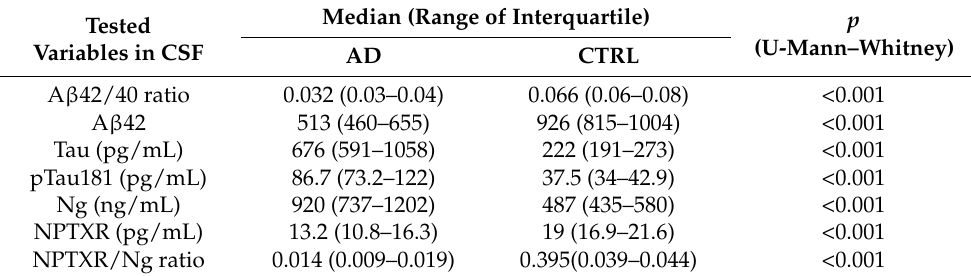
Table 2. The concentrations of tested proteins in the study groups.